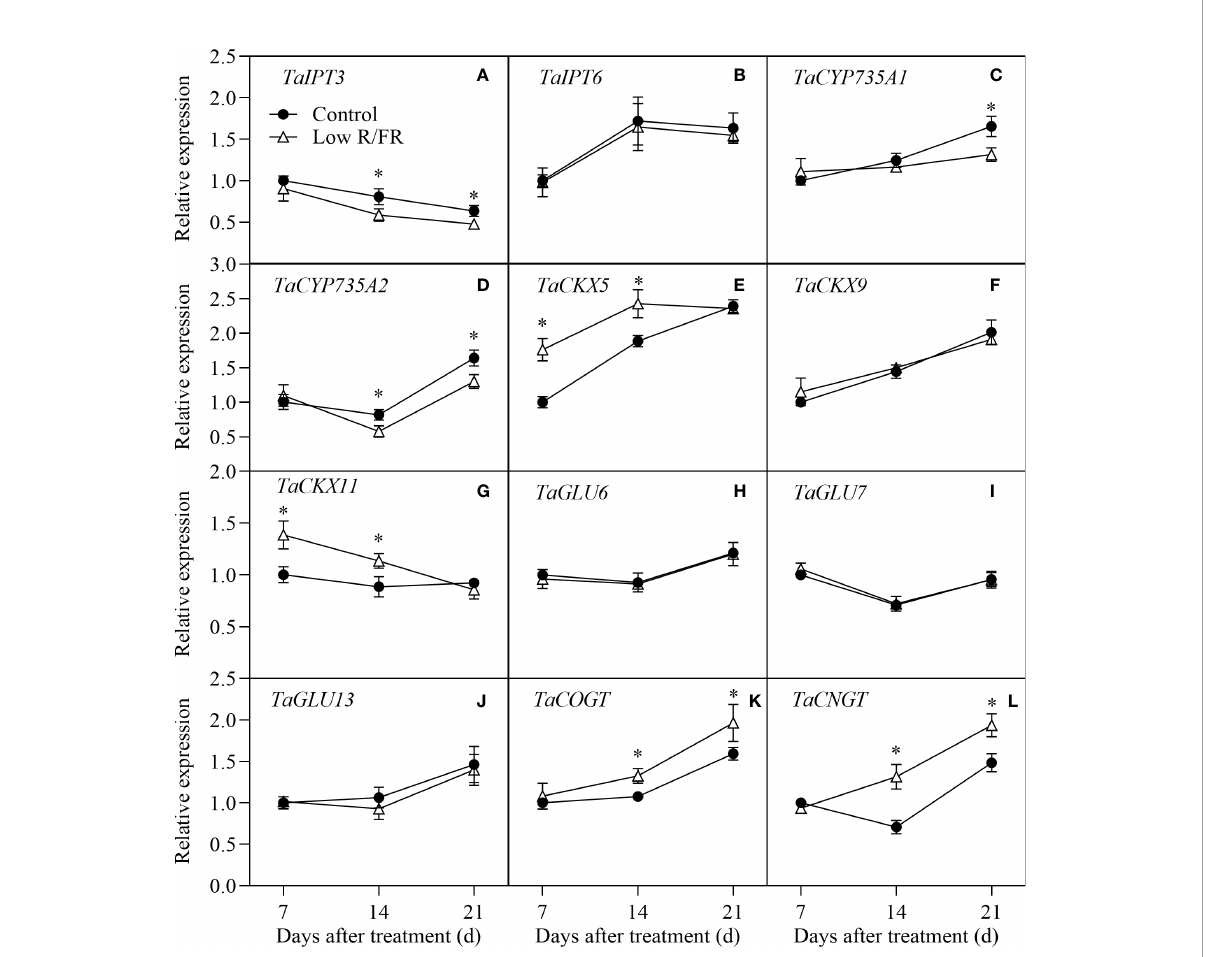
FIGURE 6 Expression of CTK metabolism genes in tiller nodes under control and low R/FR conditions. Relative transcript levels of TaIPT3 (A) , TaIPT6 (B) , TaCYP735A1 (C) , TaCYP735A2 (D) , TaCKX5 (E) , TaCKX9 (F) , TaCKX11 (G) , TaGLU6 (H) , TaGLU7 (I) , TaGLU13 (J) , TaCOGT (K) and TaCNGT (L) in tiller nodes treated for 7, 14 and 21 D. Data are the means of three biological replicates ± SE, and the asterisk denotes a statistically remarkable difference ( P < 0.05) between treated and control